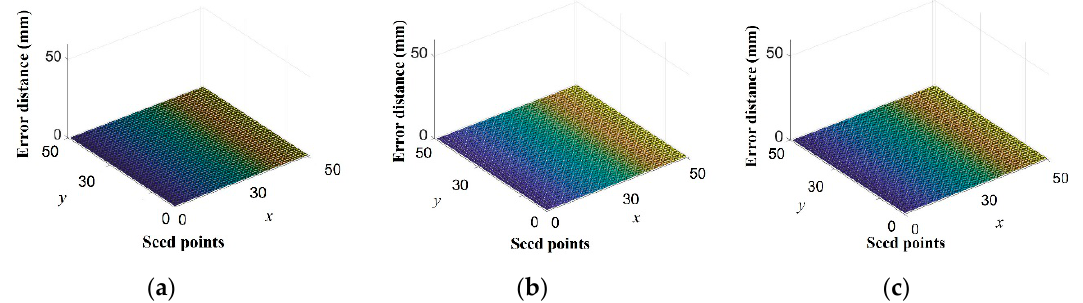
Figure 4. Validation test results of the adaptive subset sizes: horizontal displacements of ( a ) 200 μm, ( b ) 500 μm and ( c ) 1 mm.